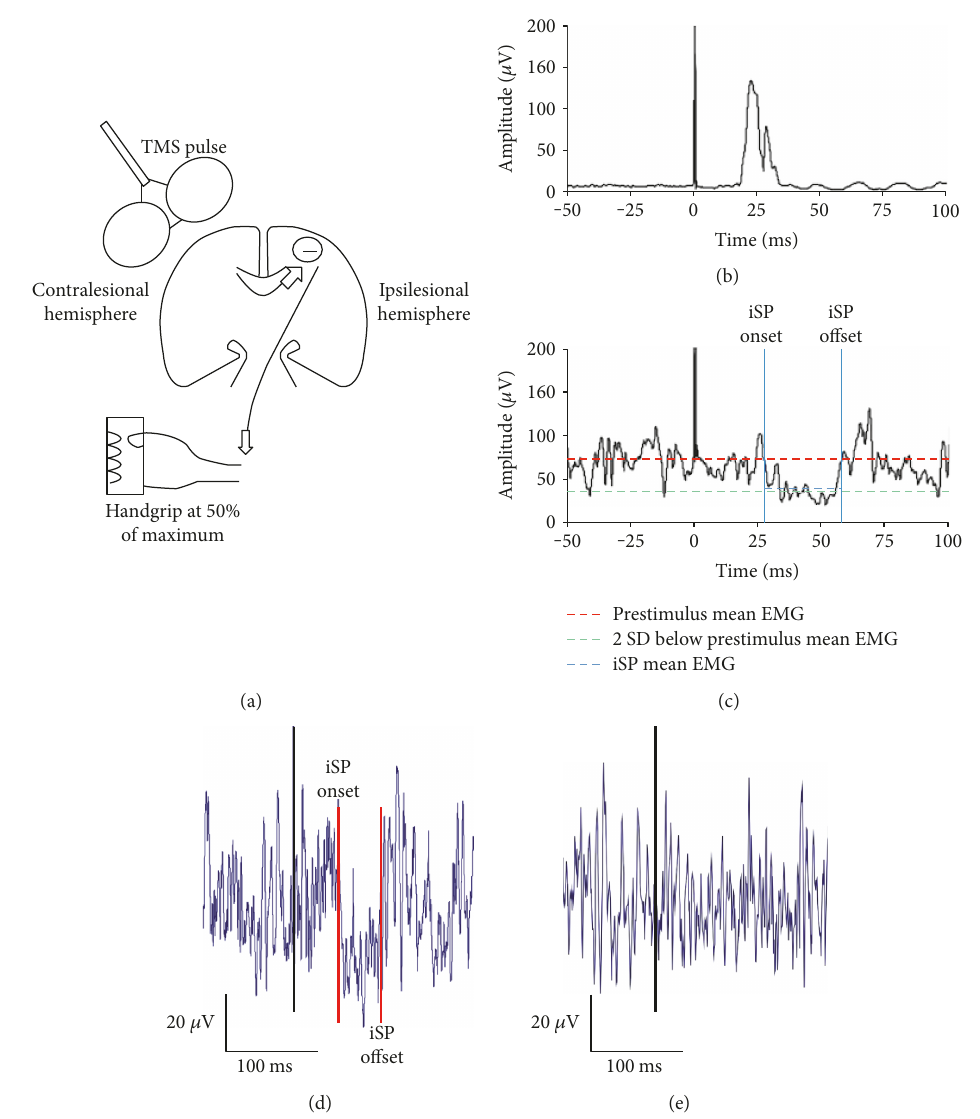
Figure 1: TMS-evoked TCI. (a) A schematic diagram of TMS-evoked TCI. Participants maintain a unilateral voluntary background muscle contraction in the arm ipsilateral to the TMS coil. A single TMS pulse is delivered to the motor cortex. The TMS pulse activates transcallosal pathways which transmit an inhibitory signal ( ─ ) to the active motor cortex. This elicits a transient quiescence in the background EMG in the active muscle. In the present example, TMS is delivered over the contralesional hemisphere to elicit the contra-iSP. TCI was also evoked with TMS delivered over the ipsilesional hemisphere to elicit the ipsi-iSP. (b) and (c) Recti fi ed EMG data collected during a TMS session from a representative participant with mild to moderate impairment. (b) The motor evoked potential collected from the contralateral ECR muscle during the TCI procedure. (c) The EMG activity and iSP collected simultaneously from the ipsilateral ECR muscles. The iSP calculated as: iSP mean EMG (blue line)/prestimulus mean EMG (red line). For ease of viewing, only 150 ms of the total 450 ms recording window is displayed. (d) and (e) Representative TCI output from the cohort of individuals with severe arm impairment. (d) The output from an individual when TCI was present. (e) The output from an individual when TCI was not